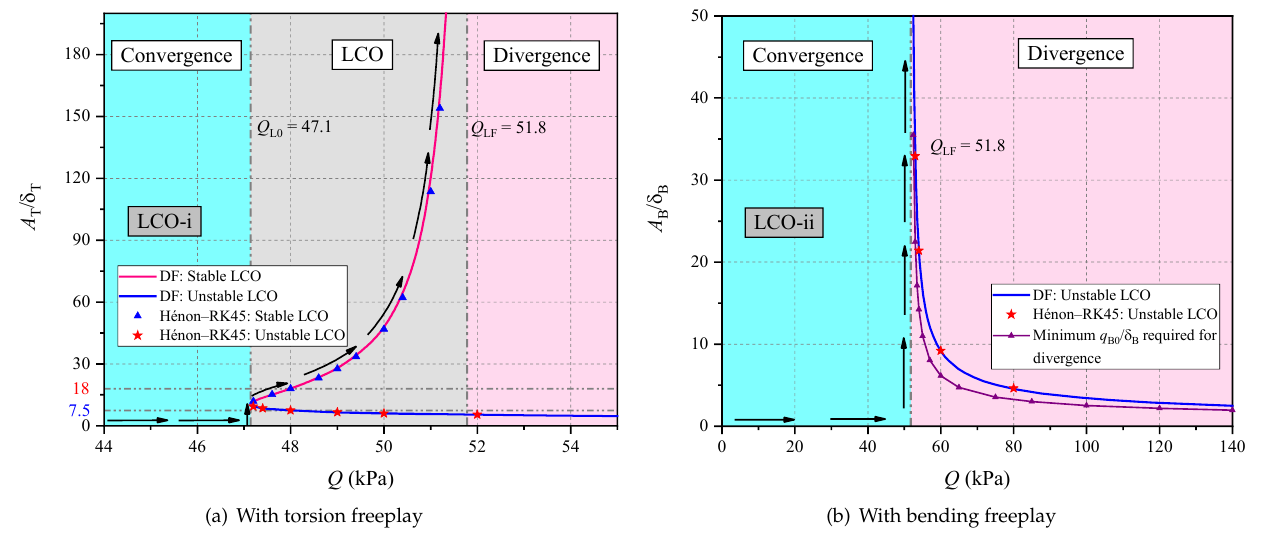
Figure 5. Nonlinear aeroelastic characteristics of an all-movable fin with torsion or bending freeplay ( K B = 5.0 × 10 3 N · m/rad, K T = 2.0 × 10 3 N ·